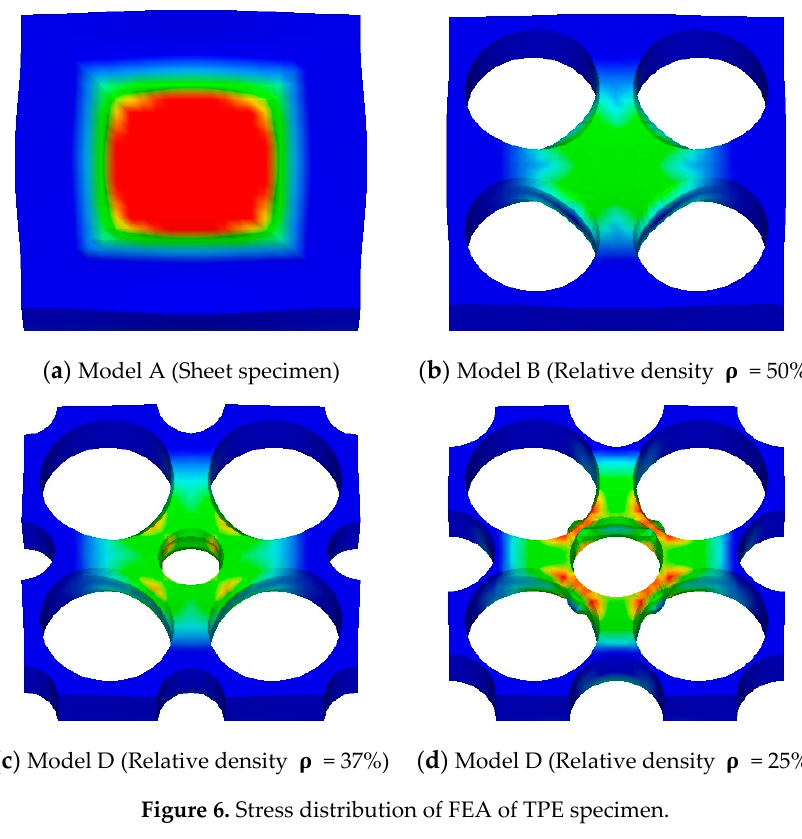
Figure 6. Stress distribution of FEA of TPE specimen.